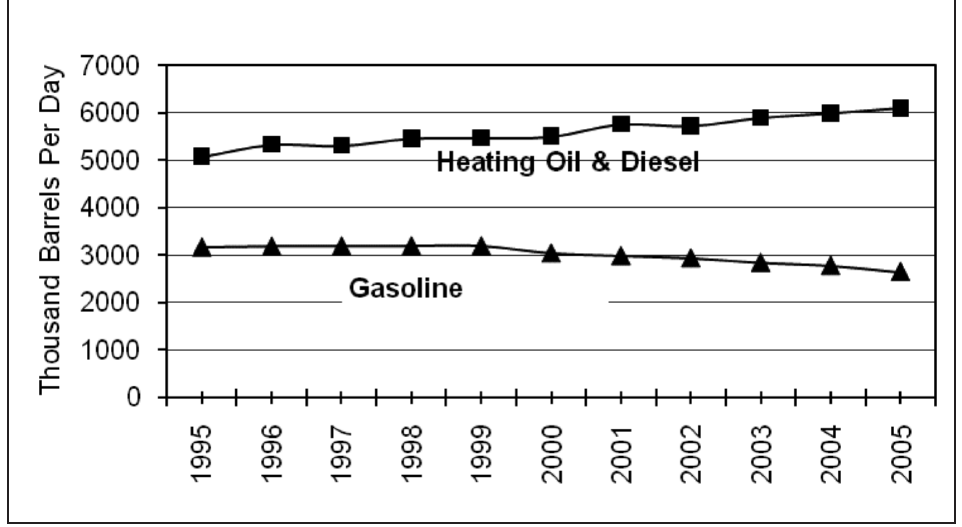
Figure 3. European Petroleum Consumption Source:Energy Information Administration website